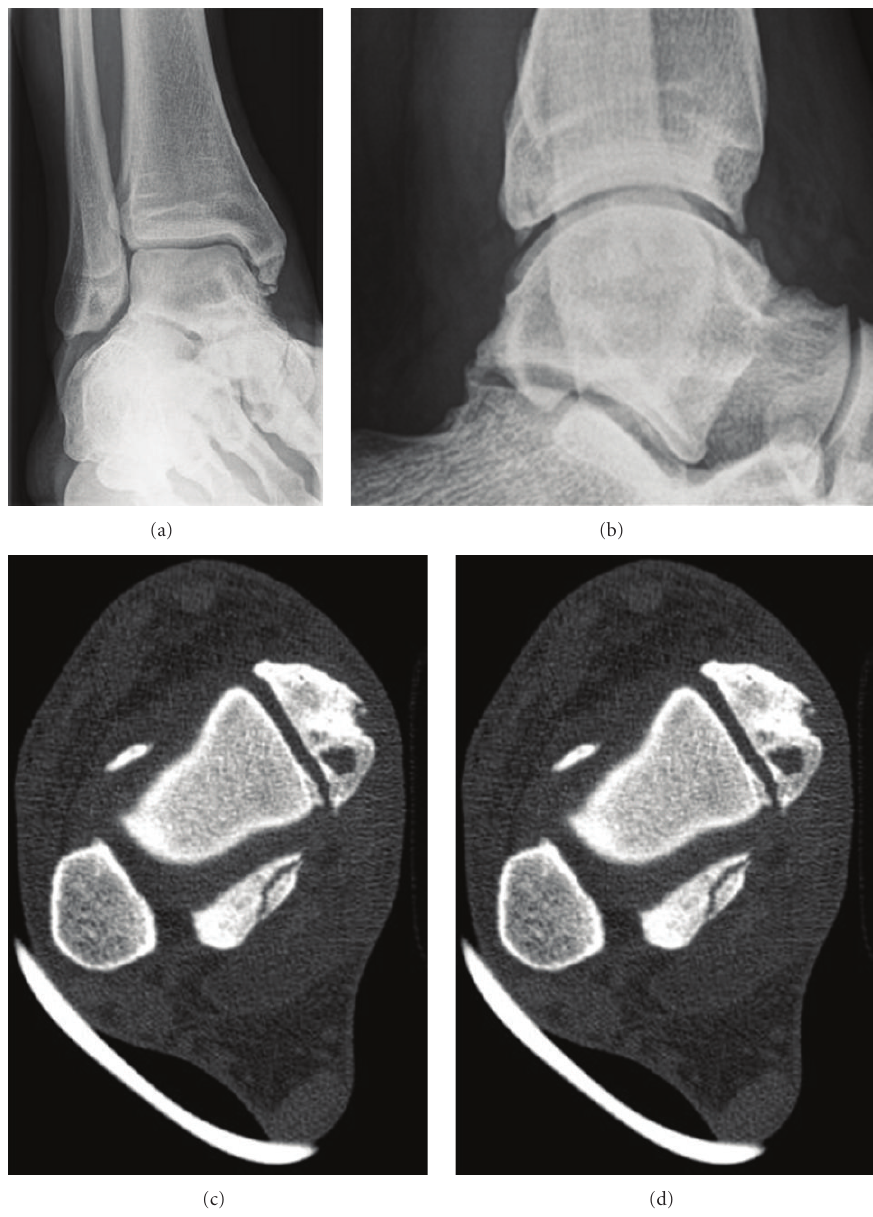
Figure 1: (a) AP radiograph showing medial malleolar ossicles. (b) Lateral radiograph showing anterior osteophytes. (c) and (d) Transversal CT slices showing the pseudarthrotic fragment of posterior distal tibial